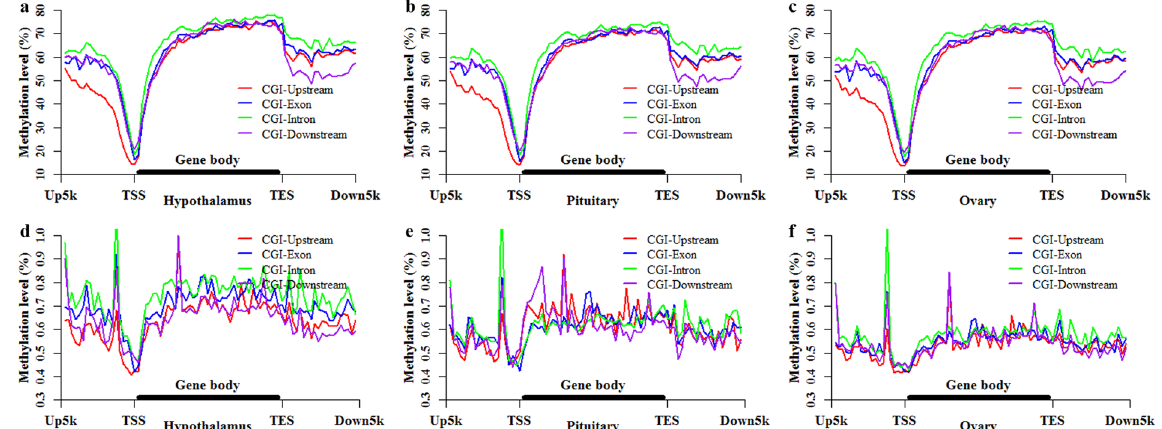
Figure 5. Methylation patterns of genes based on different genic CGIs. The CpG methylation patterns at gene locations based on the different genic CGIs in the hypothalamus ( a ), pituitary ( b ) and ovary ( c ). The CpH methylation patterns at gene locations based on the different genic CGIs in the hypothalamus ( d ), pituitary ( e ) and ovary ( f ). Genes were classified into CGI-Upstream, CGI-Exon, CGI-Intron and CGI-Downstream genes, basing on the localization of the